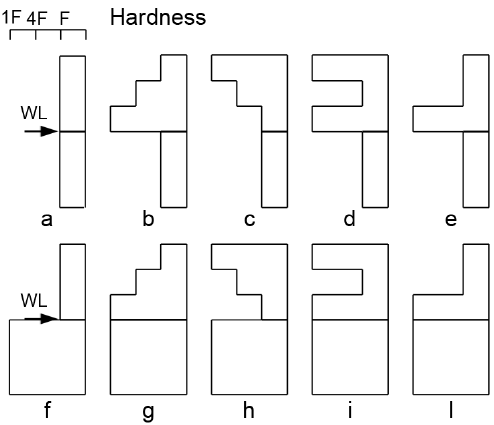
Figure 3. Ten simplified hardness profiles. The profiles from (a) to (e) have a weak base, while from (f) to (l) a strong base. The arrows highlight the depth where the weak layer was located (not to scale). The simplified profiles have the same characteristics as the ones used by Habermann et al.